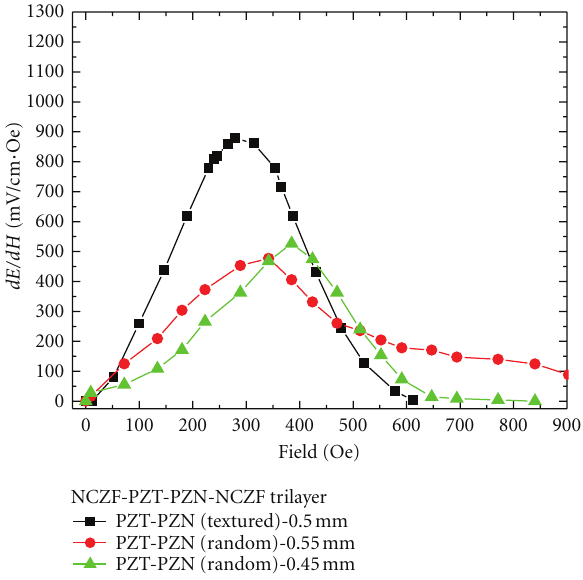
Figure 25: ME coe ffi cient of partially textured trilayer composite compared with randomly oriented